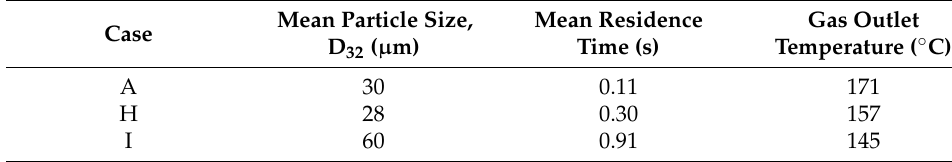
Figure 18. Product recovery at outlet and deposition in the dryer for cases A, H and I. 4. Conclusions In this study, a CFD model of skim milk drying in a novel counter flow dryer was presented. Three-dimensional, steady-state simulations were carried out using two-way coupling between the gas and discrete phase employing the Eulerian–Lagrangian multi- phase model. Drying kinetics of skim milk was incorporated using the REA approach. For model validation, numerical predictions were compared to the experimental data (tem- perature profiles and final SMD) obtained during the skim milk test. The model showed good agreement with a maximum average error of 5% for the radial probes, while an overprediction of the mean diameter was observed (30 µm against 27 µm). Furthermore, to evaluate the dryer performance, multiple cases were studied. The results revealed that nozzle position and feed rate had the most pronounced effect on product recovery, mean particle diameter, and mean residence time. Placing the nozzle at around mid-height of the dryer ( ≈ 23 cm) resulted in maximum product recovery, mean particle diameter, and mean residence time. Similar trends were observed with the maxi- mum feed rate of 26 kg/h. Here, due to increased spray penetration upstream in the dryer, the final mean particle diameter and residence time also increased.